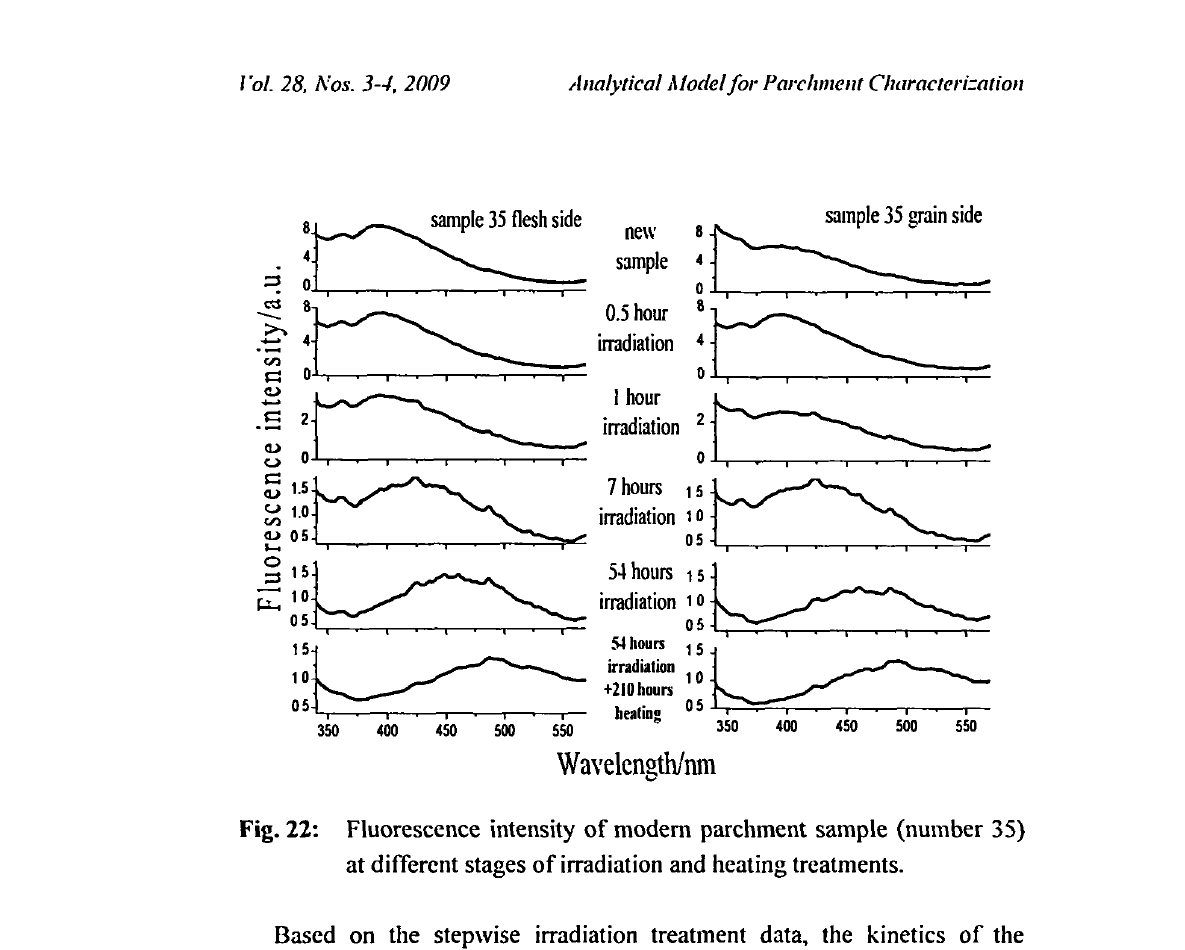
Fig. 22: Fluorescence intensity of modem parchment sample (number 35) at different stages of irradiation and heating